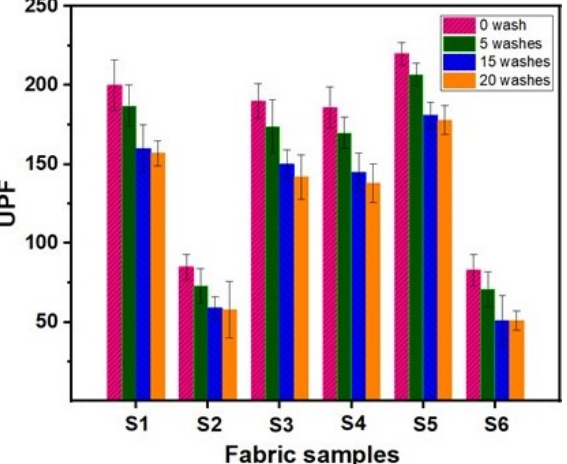
Figure 12. UPF of modified cotton fabrics before and after various washing cycles.